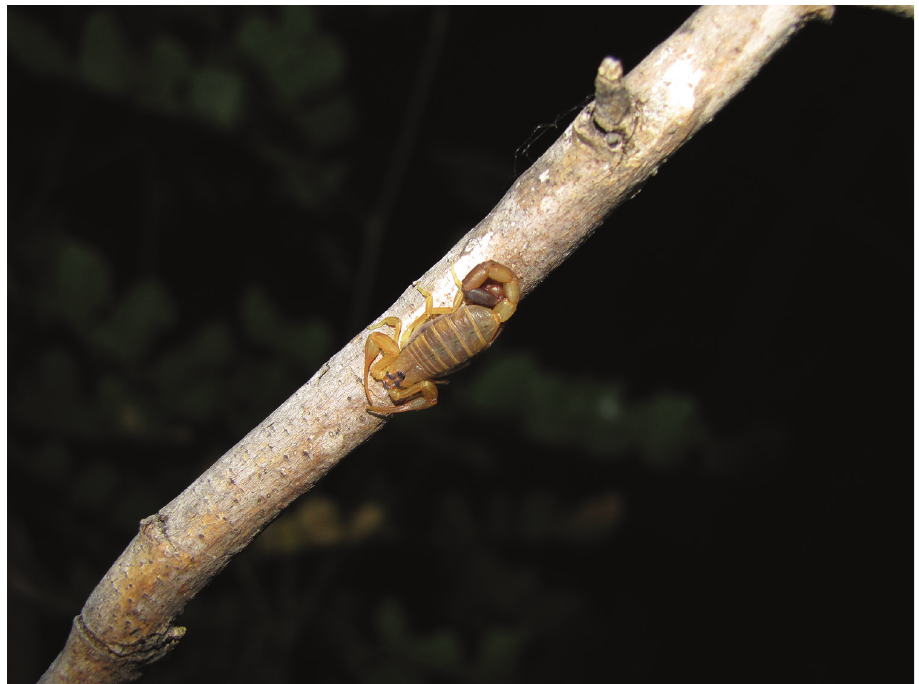
Figure 1. Physoctonus debilis , female from Juazeiro, Bahia, Brazil, in natural habitat (photograph Tiago J.